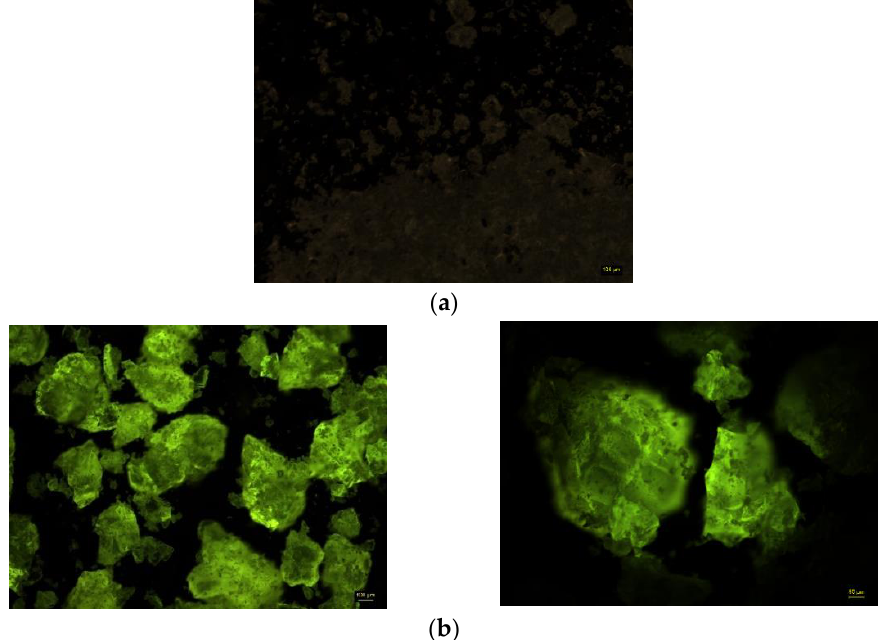
Figure 8. Fluorescent images of: ( a ) the blank sol-gel matrix (without enzyme) at 5× magnification; ( b ) the sol-gel matrix, containing FITC-labeled Candida antarctica B lipase at 5× and 10× magnification.